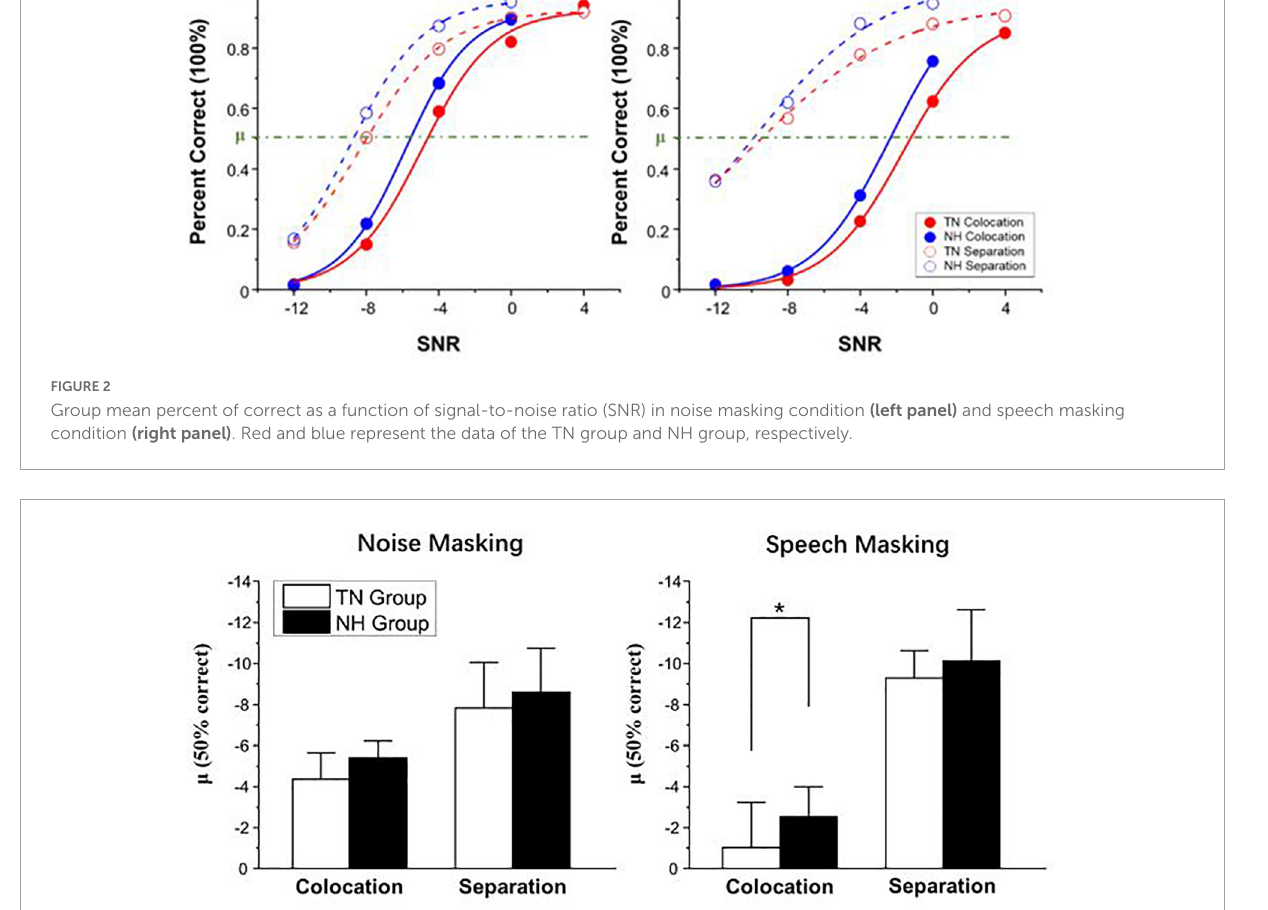
FIGURE3 Participants’ SIN perception threshold µ in noise masking condition (left panel) and speech masking condition (right panel) . * p <